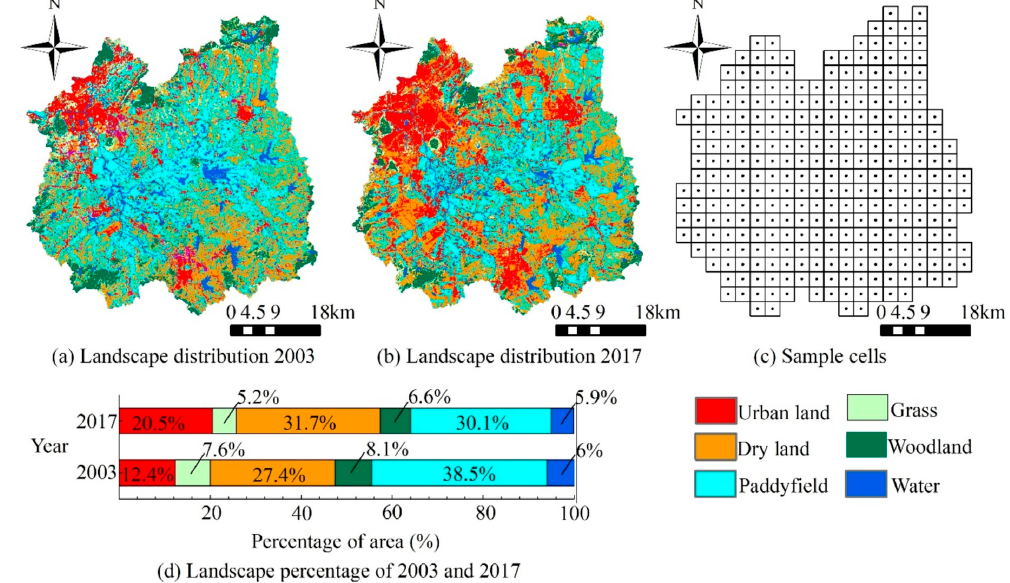
Figure 2. Landscape distribution maps and the sample cells. Table 1. The data used in the study.